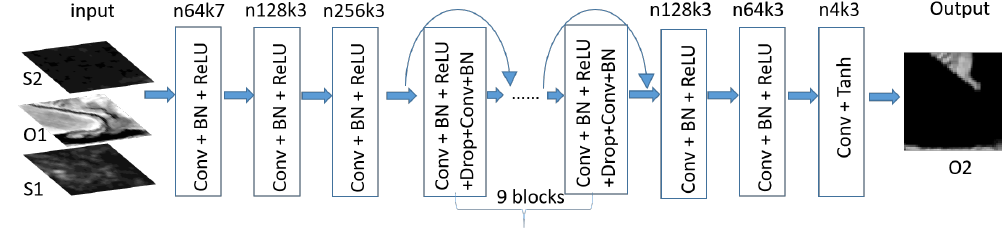
Figure 2. Illustration of the CNN generation